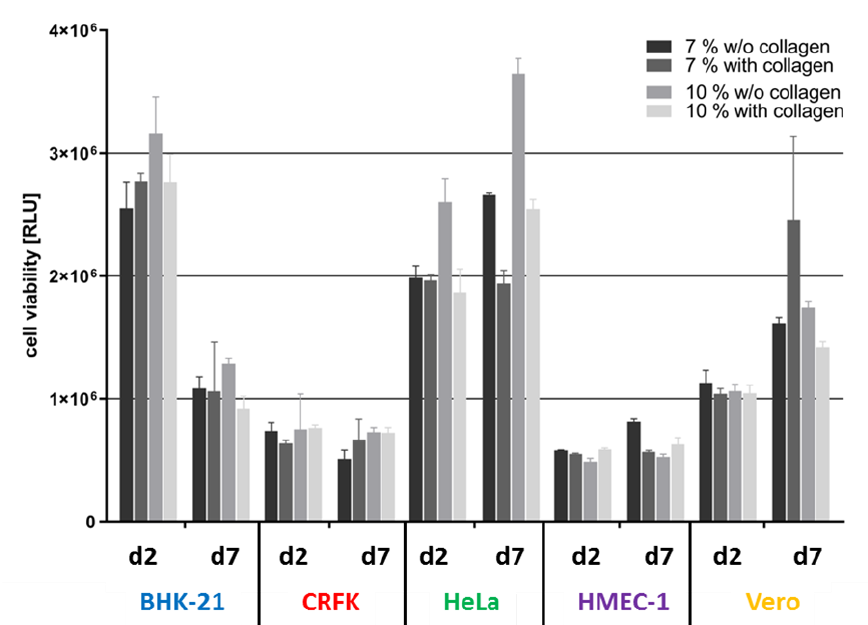
Figure 2. Influence of the Wellbrick matrix composition on the viability of different cell lines. BHK-21, CRFK, HeLa, HMEC-1, and Vero cells were seeded on Wellbricks. Cultivated cells reached confluence on day 2 and were cultivated for an additional 5 days to investigate long-term effects on viability. Cells were either grown on 7 or 10 wt% gelatine with or without 3% Collagen A supplement. Cell viability of 3D cultures was determined by ATP measurement with the CellTiter-Glo ® cell viability assay.